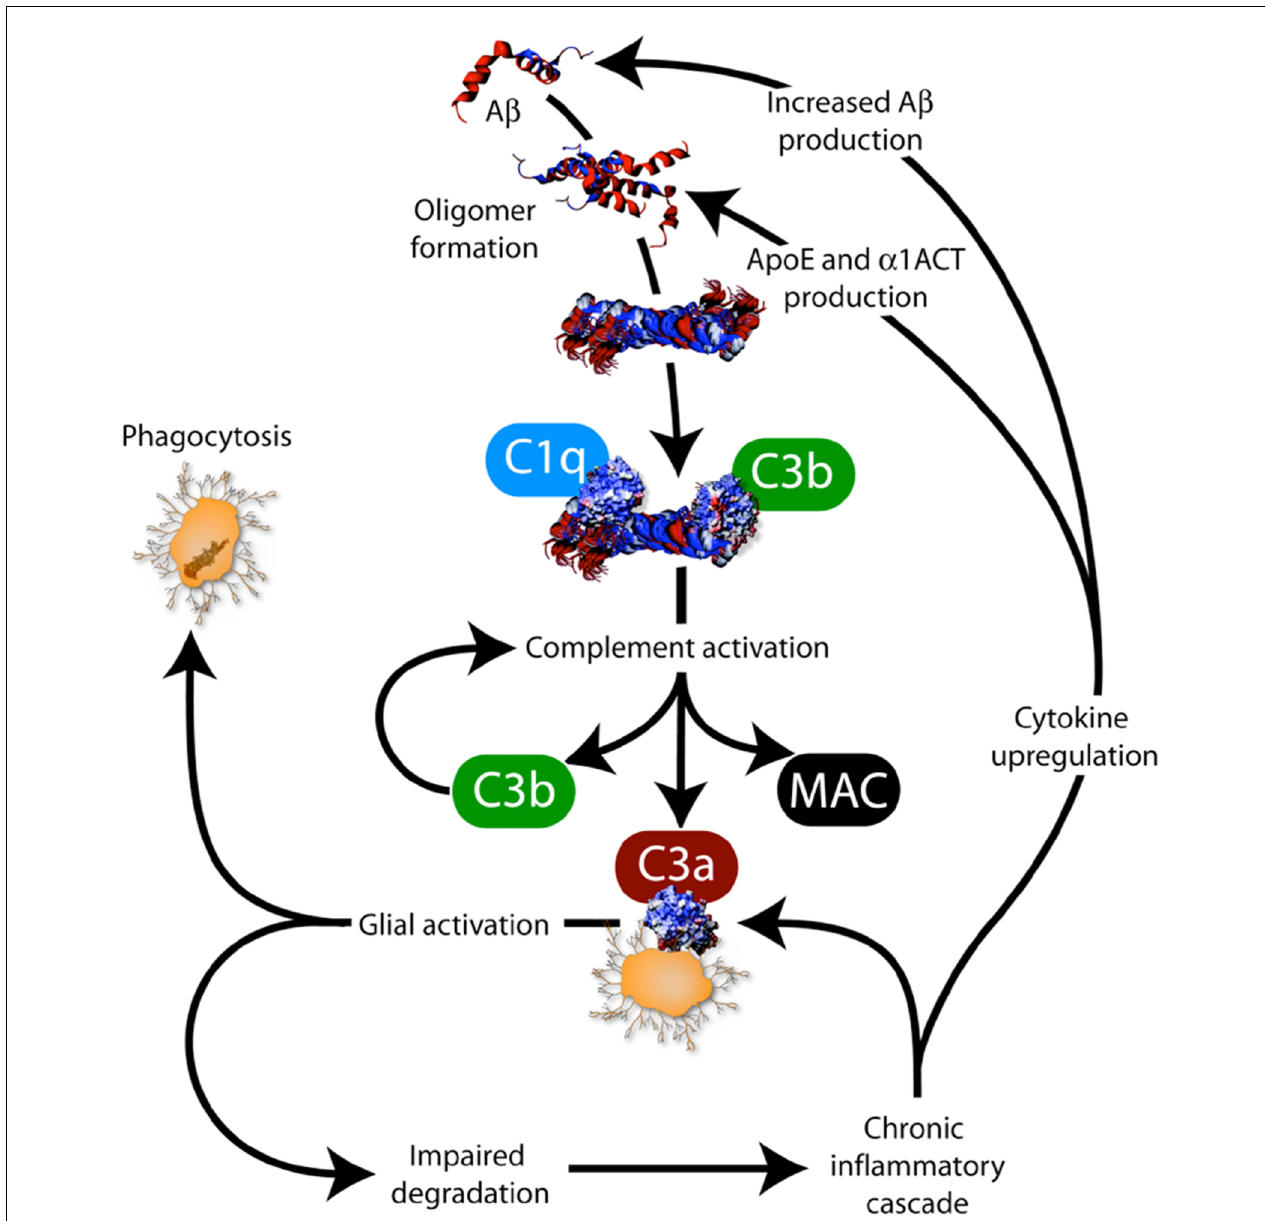
tumor necrosis factor α (TNF- α ) and TGF- β , ApoE is apolipoprotein E and α 1-antichymotrypsin ( α 1-ACT) is an acute phase reactive protein (from Weggen et al.,